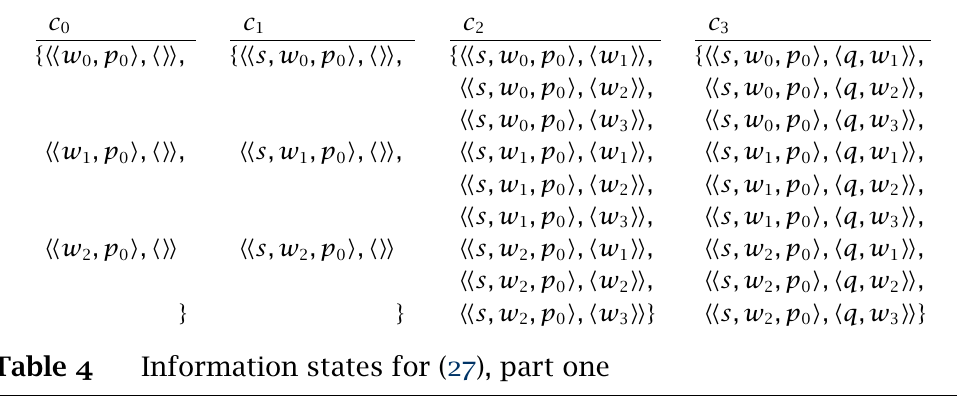
Table 4 Information states for ( 27 ), part